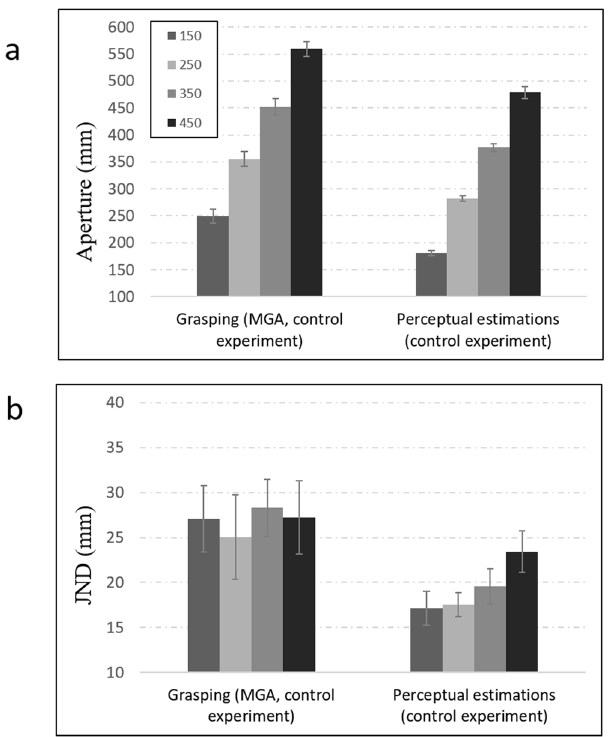
Figure 4. Average grip apertures ( a ) and JNDs ( b ) at the point of maximum grip aperture (MGA) in the control experiments during grasping and perceptual estimations. As in the main experiment, perceptual estimations adhered to Weber’s law whereby grasping trajectories were immune to Weber’s law. Error bars represent standard errors of the